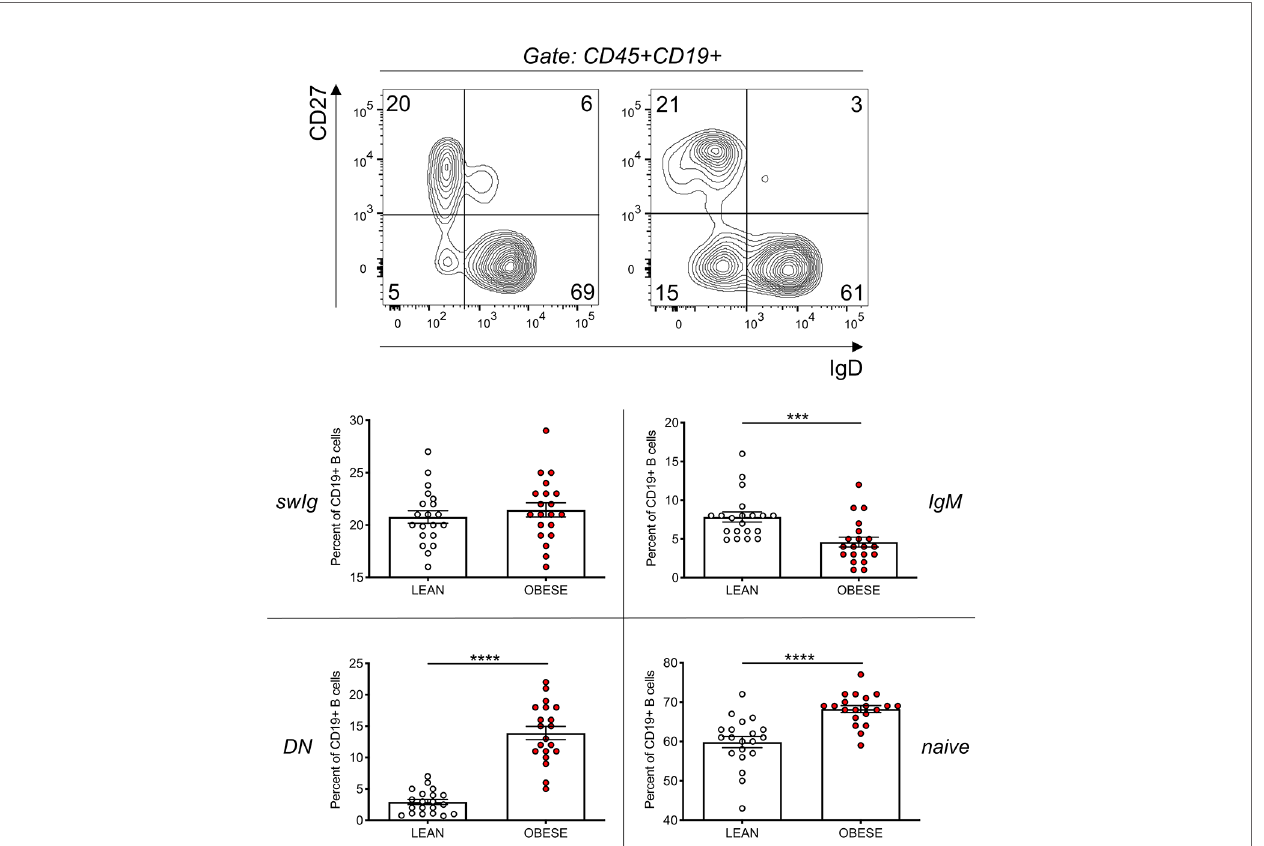
Student ’ s t test (two-tailed). ***p < 0.001, ****p < 0.0001.